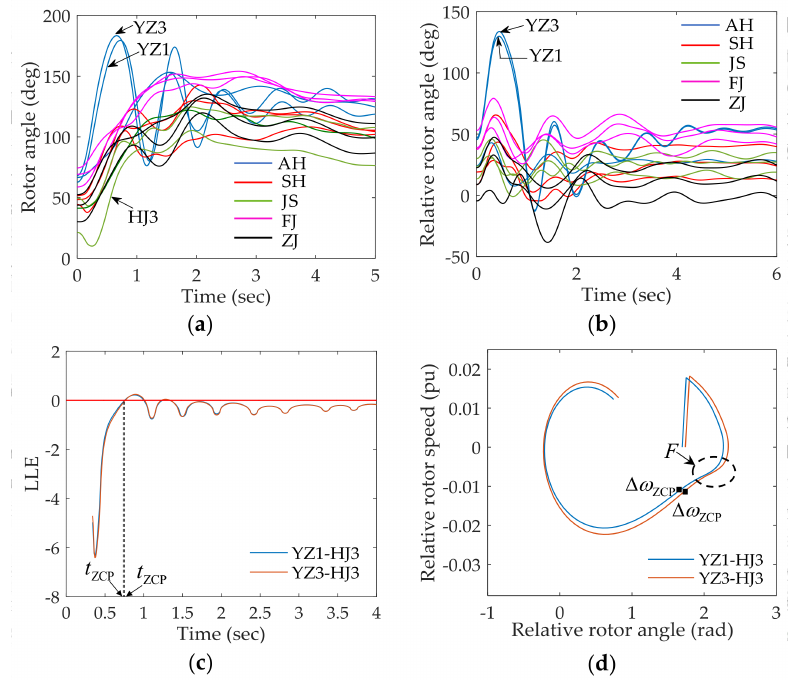
Figure 10. Simulation results for Case 3: ( a ) Rotor angle curves of generators after fault; ( b ) relative rotor angle curves after fault (HJ3 is the reference generator); ( c ) LLE–time curves; ( d ) phase-plane trajectories after clearing the fault.